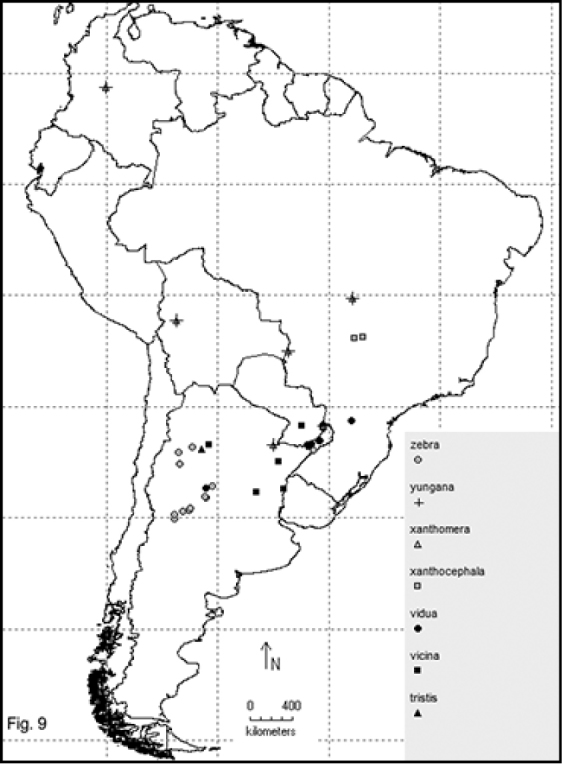
New distribution records for: E.tristis; E.vicina; E.vidua; E.xanthocephala; E.xanthopterus; E.yungana; and E.zebra.